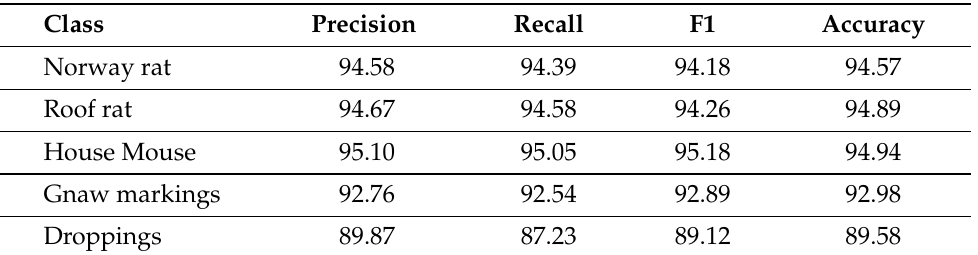
Table 2. Statistical measures for rodent activity detection framework.